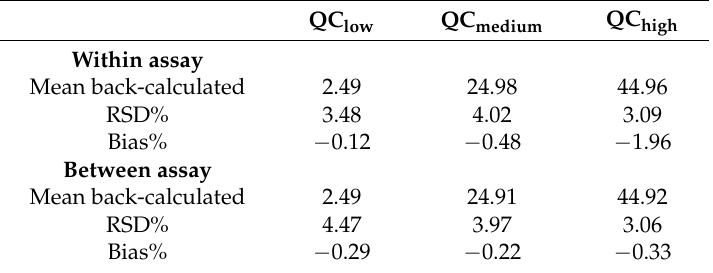
Table 1. Within-assay and between-assay precision (RSD%) and trueness (bias%) of the HPLC run. QC low QC medium QC high Within assay Mean back-calculated 2.49